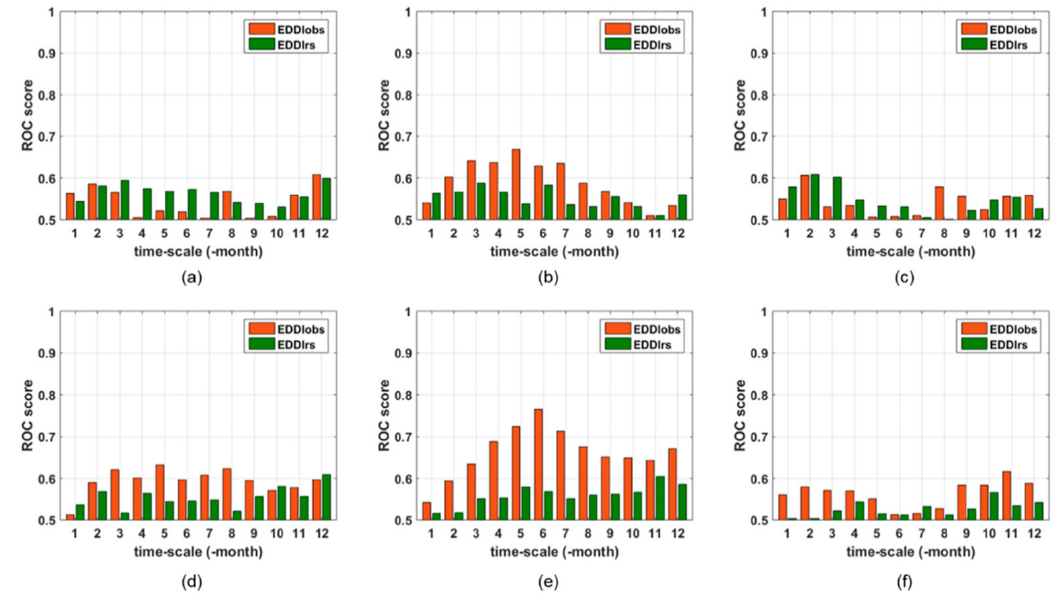
Figure 5. ROC scores of EDDI at ( a ) Chungcheong, ( b ) Gangwon, ( c ) Gyeongbuk, ( d ) Gyeongnam, ( e ) Gyeonggi and ( f ) Jeolla. The horizontal axis is the time scale of the drought index, and the vertical axis is the ROC scores of the EDDI calculated at each time